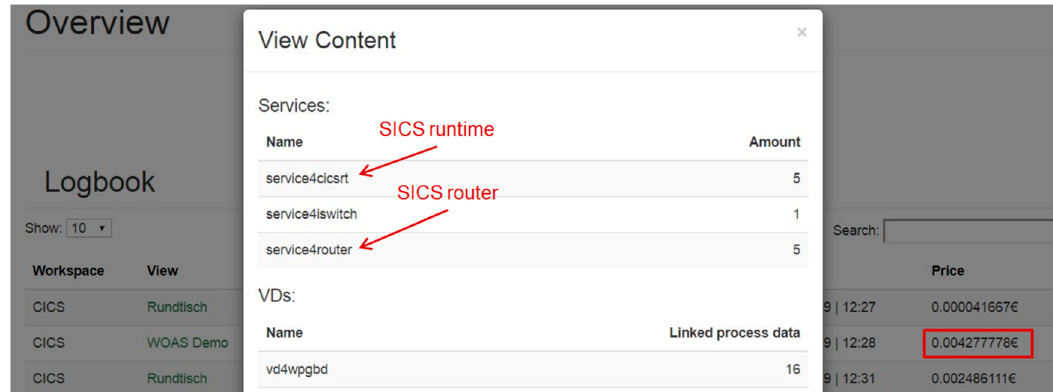
Figure 14. Settlement and analysis in the clearing system for an example with five SISC-SMM controller instances.